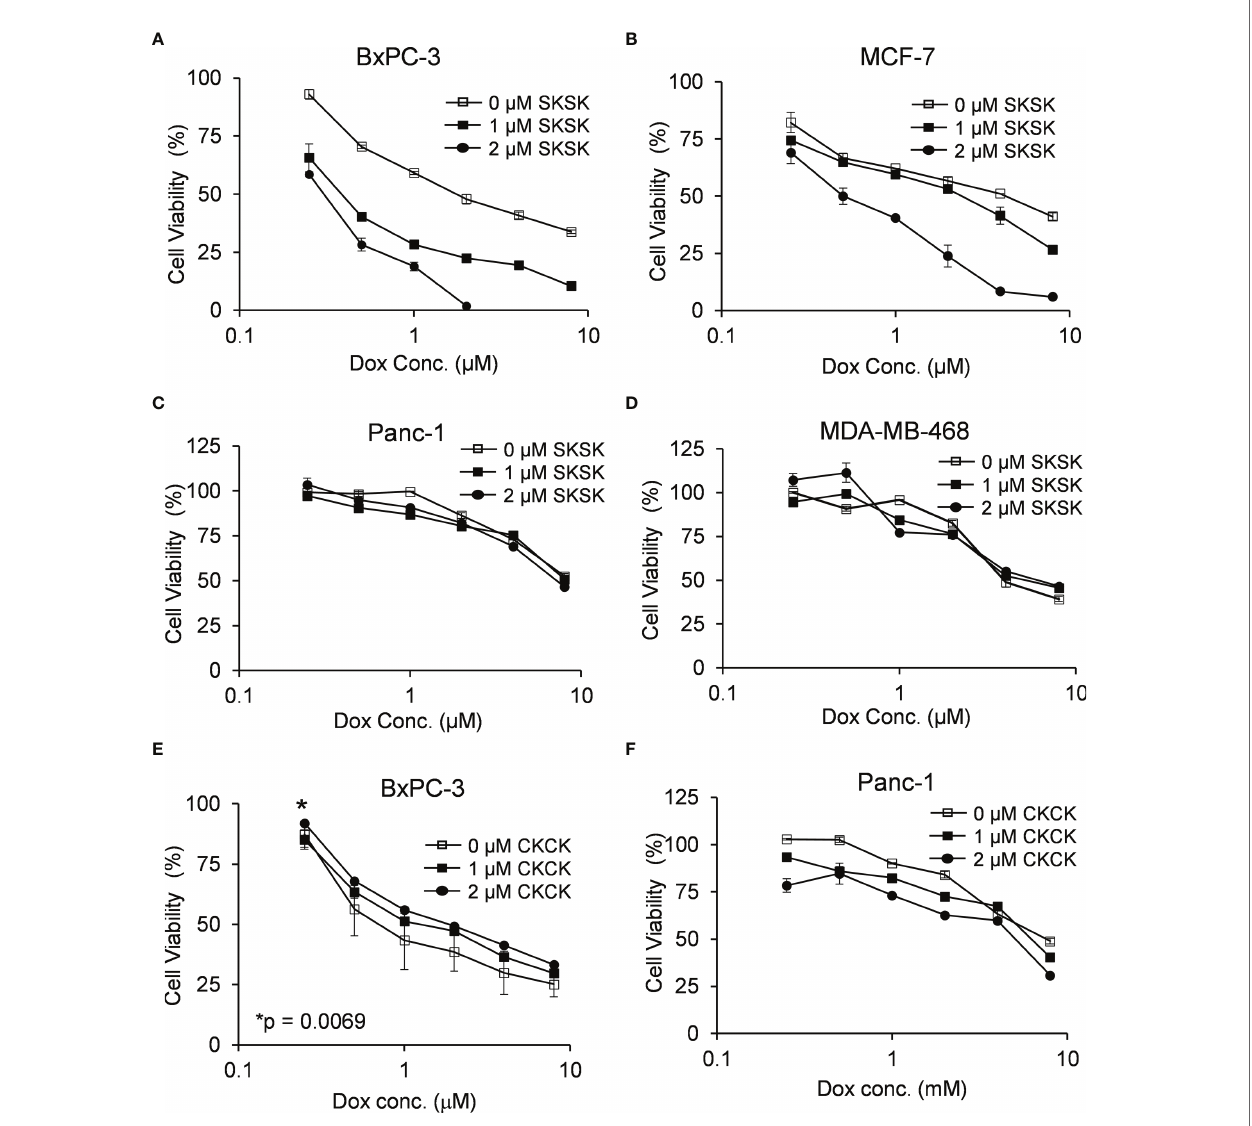
FIGURE 4 | Effect of FXYD3-pep SKSK and FXYD3-pep CKCK on cell viability with co-exposure to Dox. Viability of (A) BxPC-3 cells, (B) MCF-7 cells. (C) Panc-1 cells, and (D) MDA-MB-468 cells when treated with Dox and 0, 1, or 2 µM FXYD3-pep SKSK for 48 h Viability of (E) BxPC-3 cells and (F) Panc-1 cells treated with Dox and FXYD3-pep CKCK for 48 h * in panel € refers to a signi fi cantly increased viability with exposure of cells to 2 µM FXYD3-pep CKCK compared with exposure to solutions free of the peptide. Results are from 5 experiments for each peptide